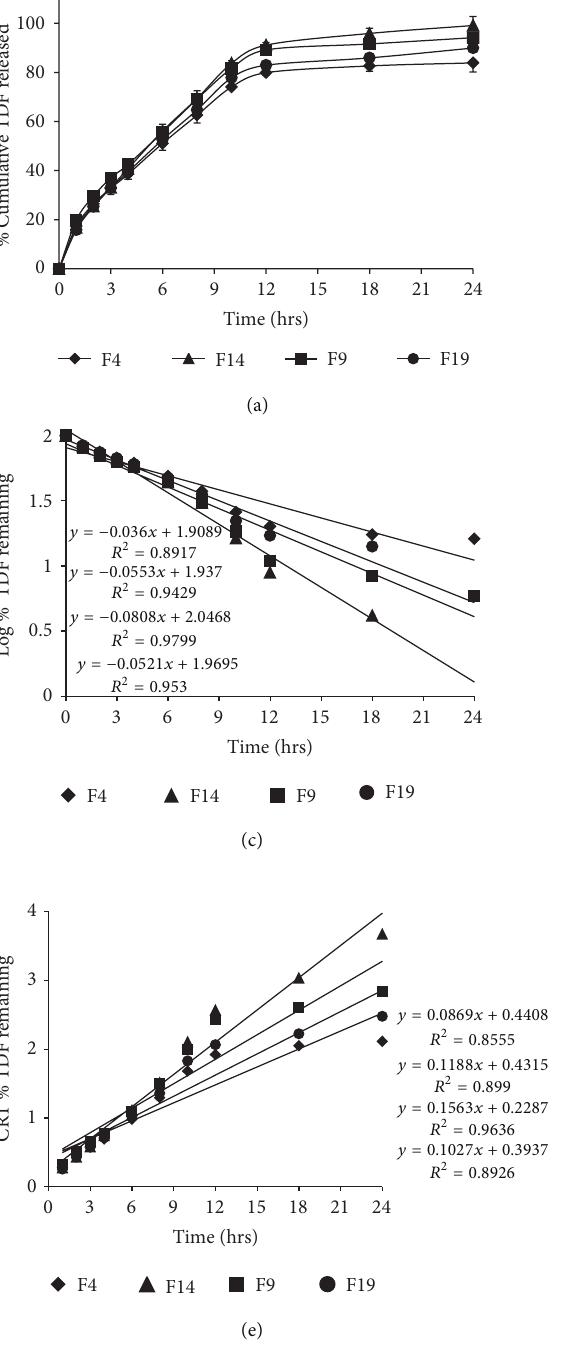
Figure 4: Comparative plots of (a) in vitro release profile, (b) zero order release kinetics, (c) first order release kinetics, (d) Higuchi (SQRT) release kinetics, (e) Hixson-Crowell model, and (f) Korsmeyer-Peppas model for the selected niosomal formulations.